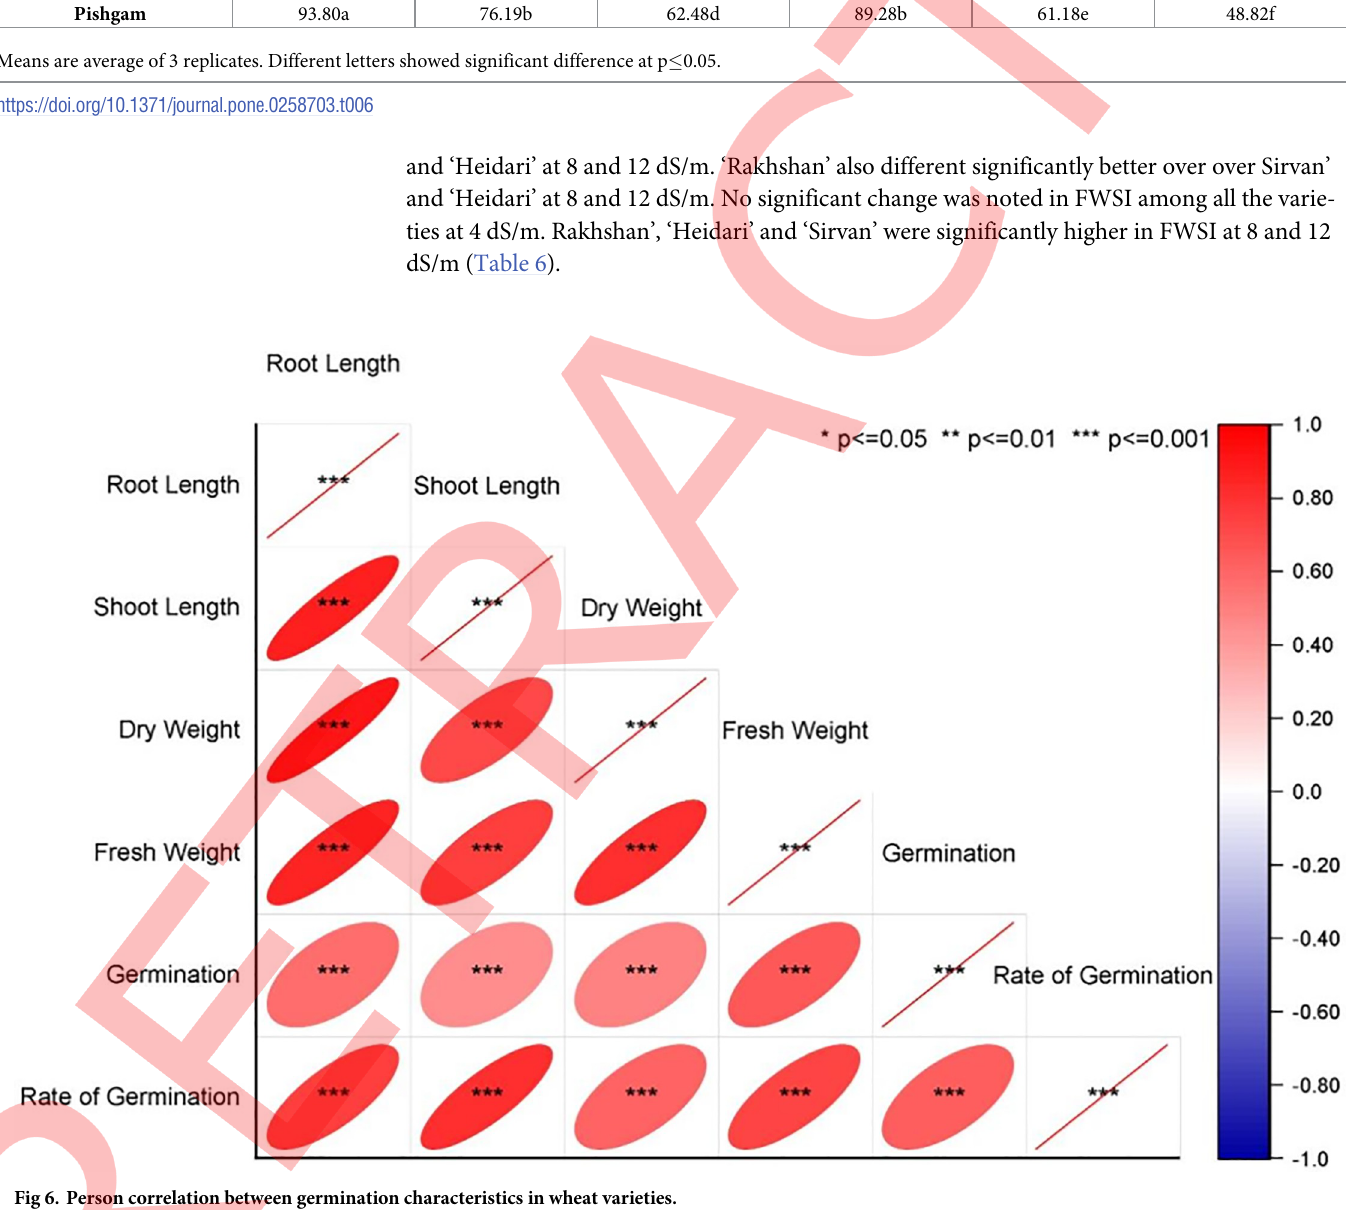
Fig 6. Person correlation between germination characteristics in wheat